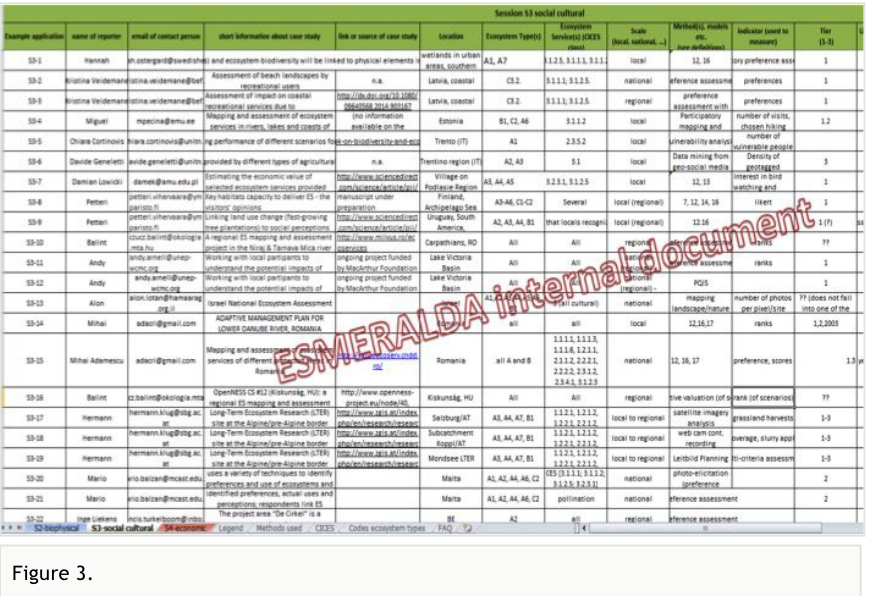
Developing the fi rst version of ESMERALDA database, which included scienti fi c and grey literature from ecosystem service mapping and assessment methods.